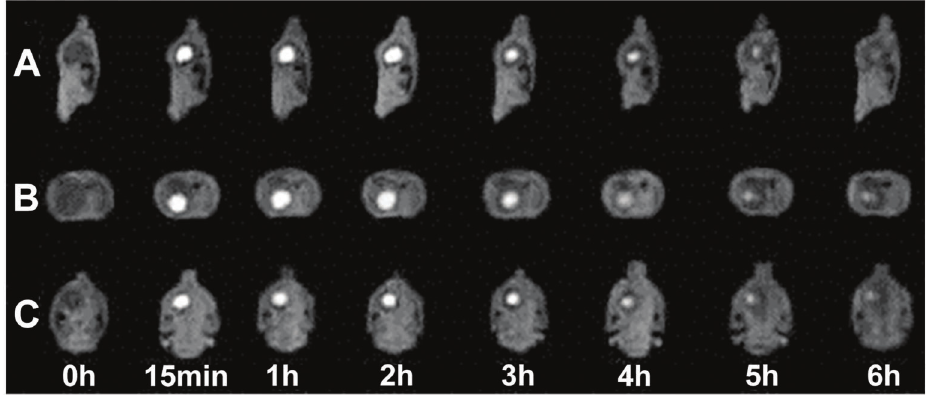
Figure 2. Spatiotemporal distribution of gadolinium-diethylenetriamine pentaacetic acid (Gd-DTPA) injected into the 20-day glioma. Sagittal views ( A ), axial views ( B ), and coronal views ( C ) over time before and after injection of Gd-DTPA.